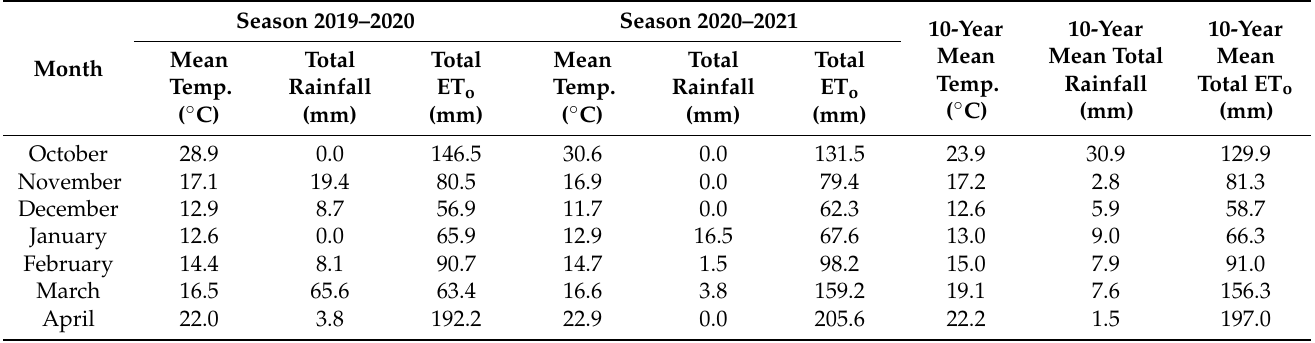
Table 1. Monthly mean temperature, total rainfall, and ET o at CIMIS Meloland station #87 for the 2019–2020 and 2020–2021 seasons, as compared with 10-year means. October through April is considered a typical carrot crop season in the region. ET o is refrense